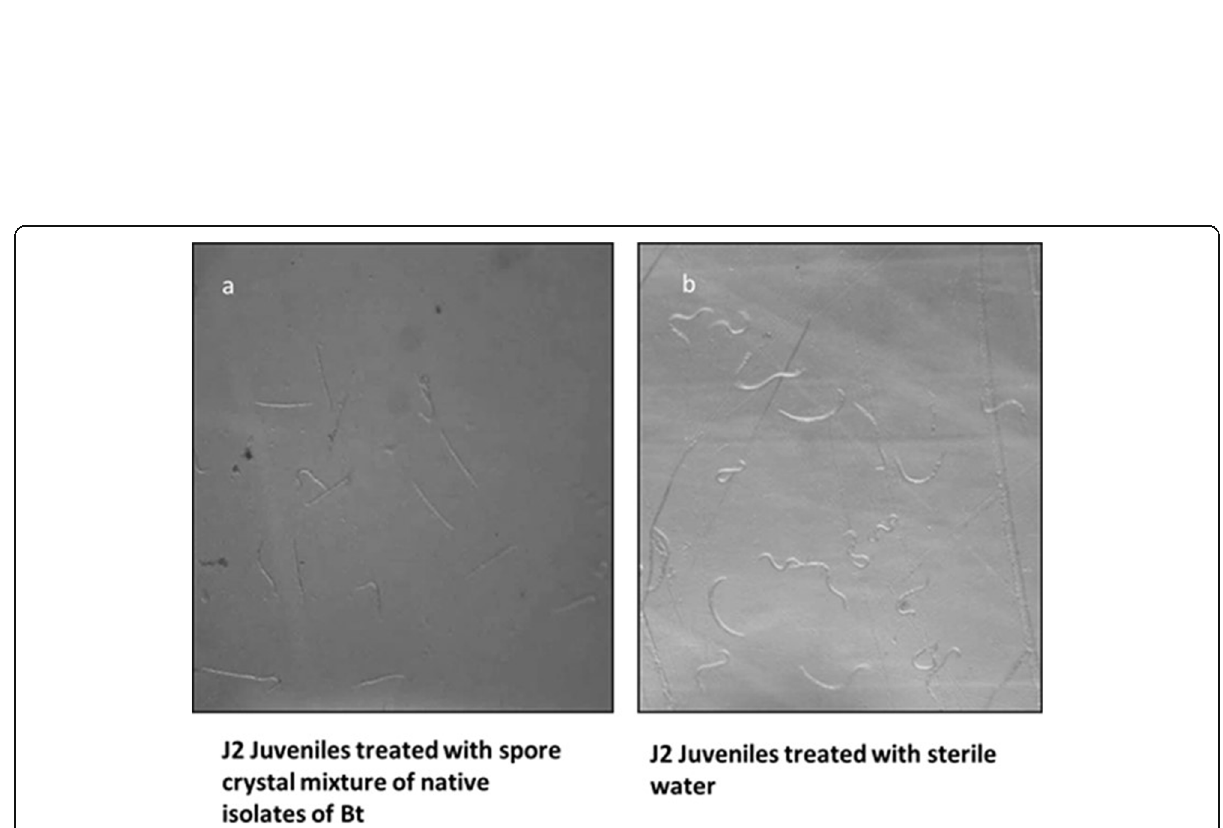
Fig. 5 Mortality of J2 juveniles by spore-crystal mixtures of native isolates of Bacillus thuringiensis . a Dead J2 juveniles (no movement) after treatment with spore-crystal mixture of native isolates of Bt . b Live juveniles with movement were observed in